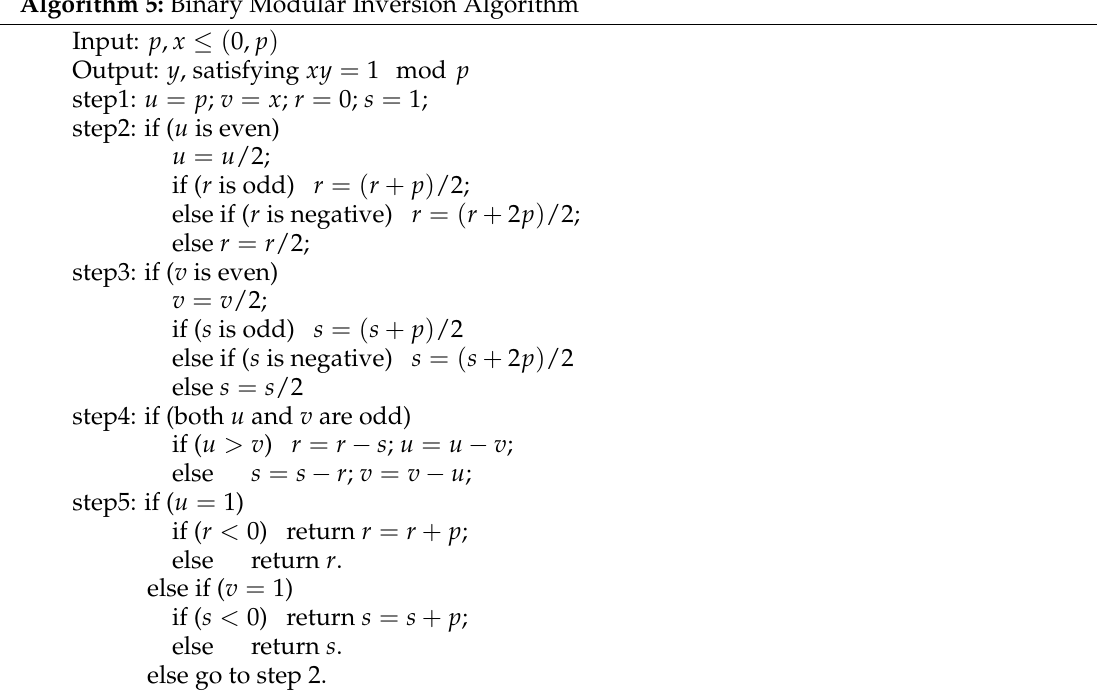
Algorithm 5: Binary Modular Inversion